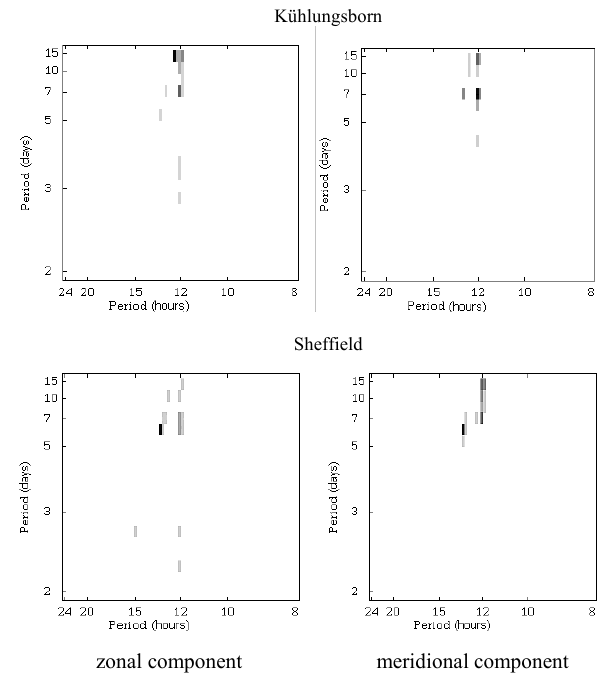
Fig. 4. Bispectra estimated for the hourly wind data of the Western European sites. Data time interval covers 1024h from first days of